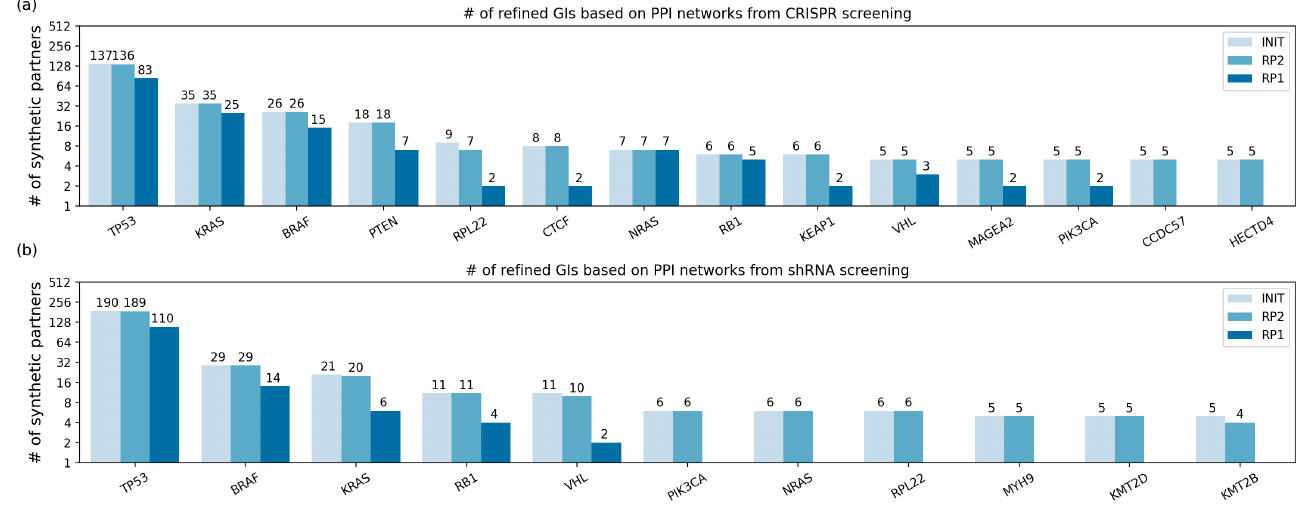
Figure 5. The number of refined GIs based on PPI networks from ( a ) CRISPR screening and ( b ) shRNA screening. Among all results, only the mutated genes with five or more initial GIs are presented. The y -axis is log-scale, and the x -axis indicates each mutated gene. INIT: the initial GIs after mapping on the PPI networks (no RP was applied). RP2: GIs after applying RP2 to the initial GIs. RP1: GIs after applying RP1 to the initial GIs. RP: refining process.